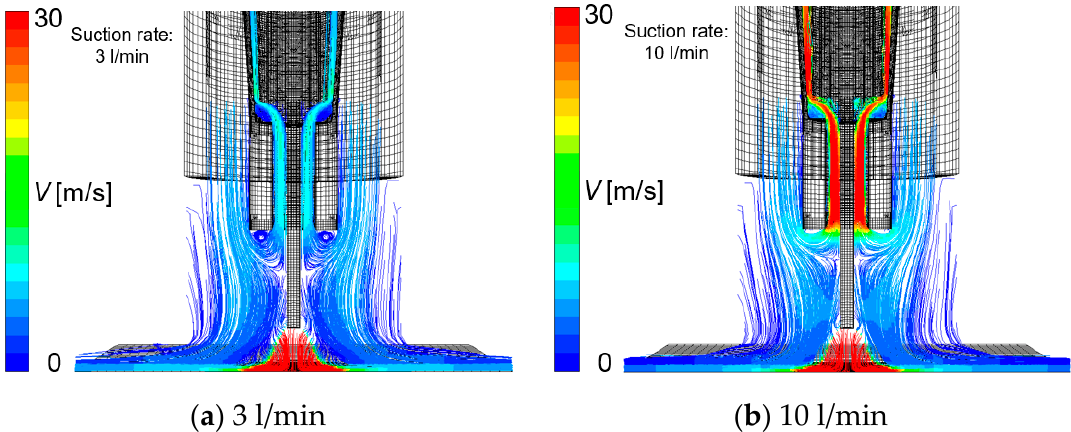
Figure 10. The effect of the suction rate on gas flow velocity: ( a ) 3 l/min, ( b ) 10 l/min.